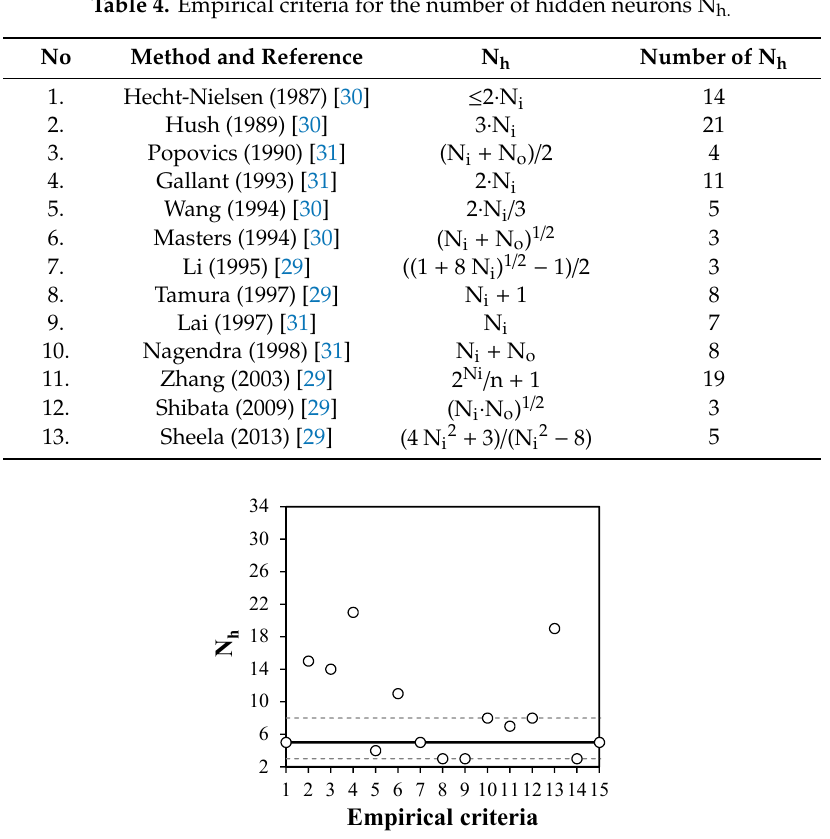
Table 4. Empirical criteria for the number of hidden neurons N h.